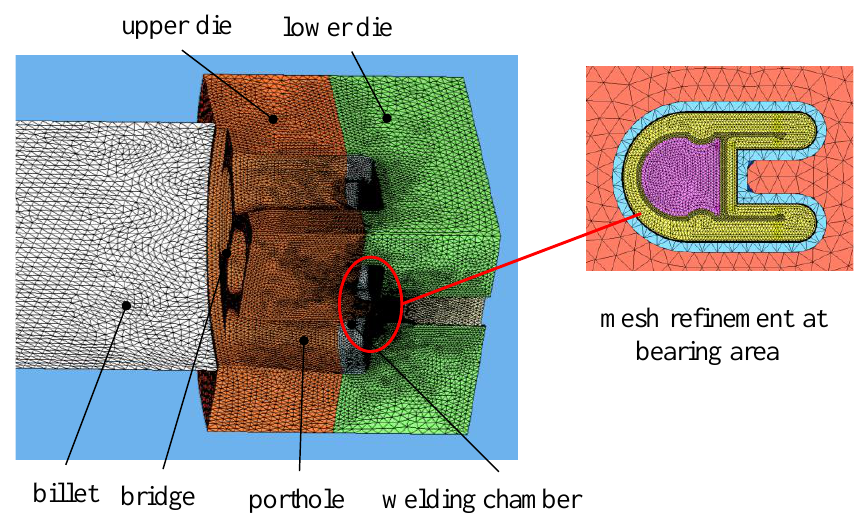
Figure 7. Finite element modelling of the multi-output porthole extrusion.